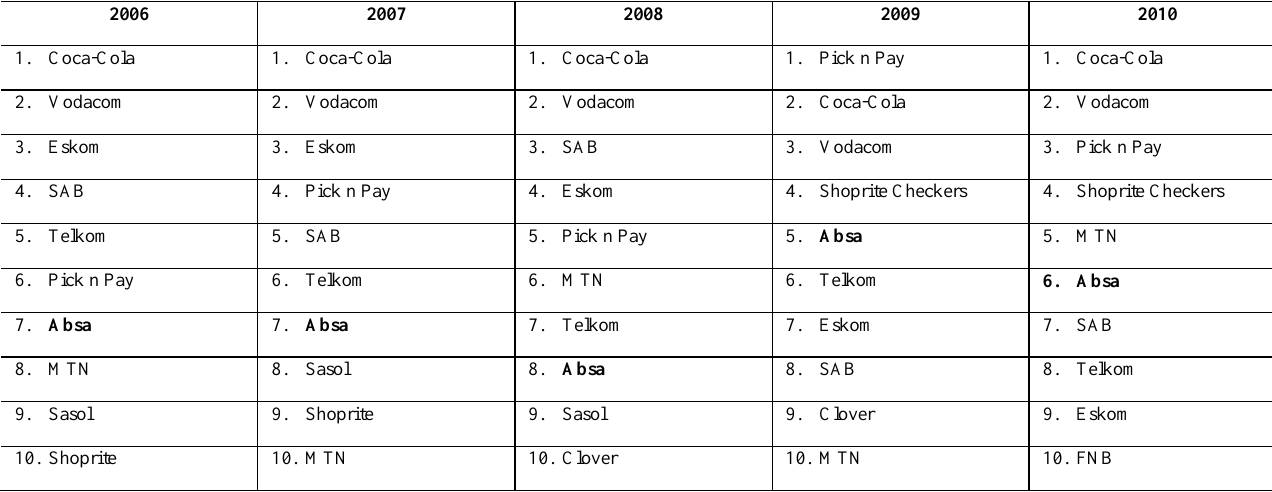
Table 2: South Africa’s top brands – Community upliftment (2006 –